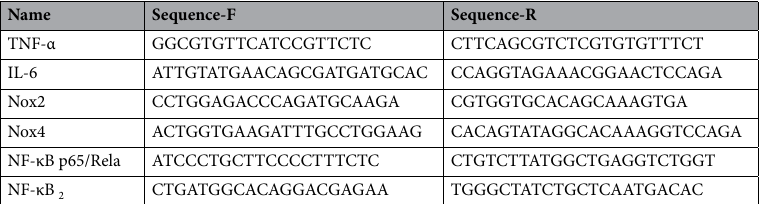
Table 1. Primer sequences for quantitative real-time polymerase chain